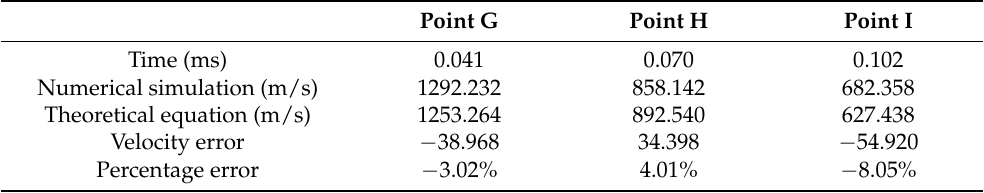
Table 12. Velocity error analysis.